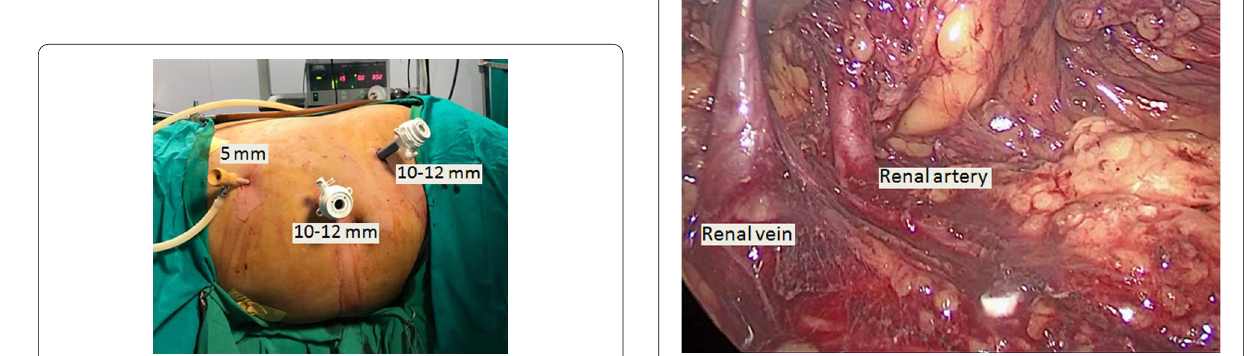
Fig. 1 Trocar position for Lt LDN